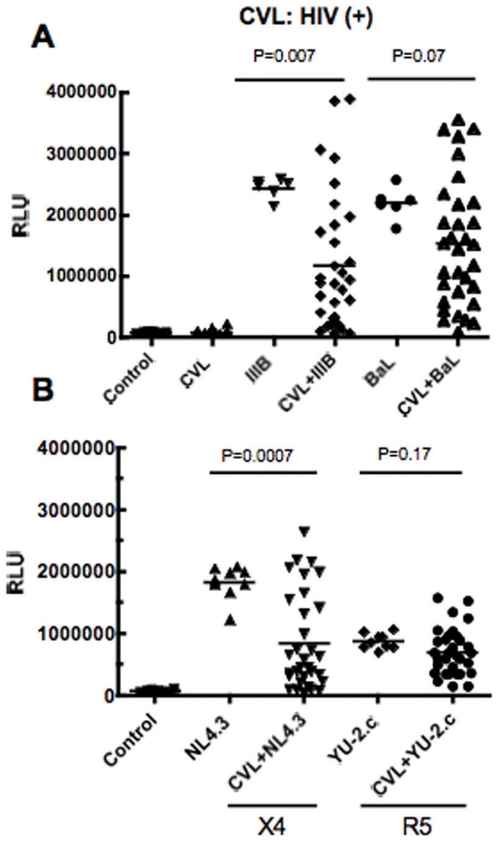
Measurement of antiviral activity in CVL from HIV(+) women.Thirty two HIV(+) CVL were diluted 1∶4 and incubated with HIV-1 IIIB (X4-tropic) and BaL (R5-tropic) (Panel A) or NL4.3 (X4) and YU-2.c (R5) (Panel B) at a multiplicity of infection (MOI) of 1 for 1h at 37°C prior to infecting TZM-bl cells. Data points in each graph represents one individual patient. Media, “Control”, and “CVL only” wells (Panel A) were set up as negative controls, and replica wells of virus (IIIB, BaL, NL4.3 and YU-2.c) were set up as positive controls. Significant differences (p values) between the mean of the control (virus alone) and that of the cognate virus+CVL are shown in the Figure.